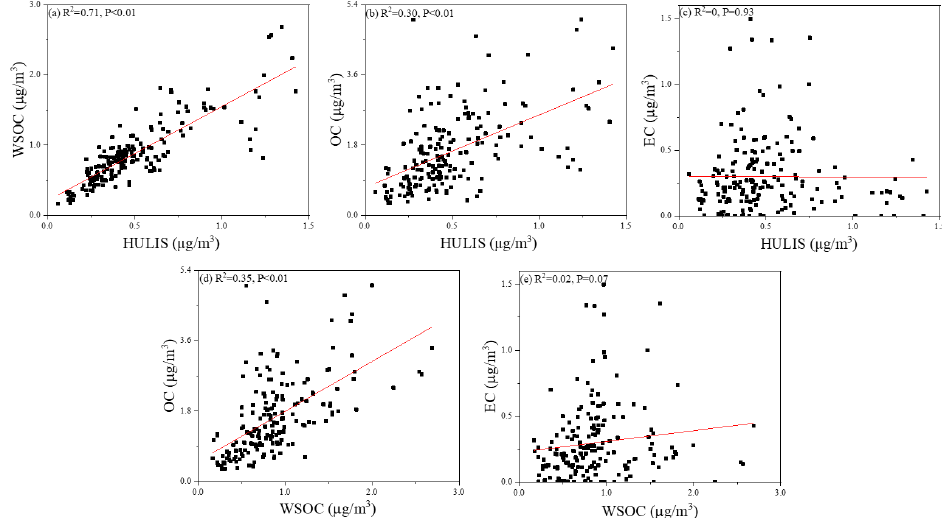
Figure 6. Correlation analysis between WSOC and HULIS-C ( a ), HULIS-C and OC ( b ), HULIS-C and EC ( c ), WSOC and OC ( d ), WSOC and EC ( e ).